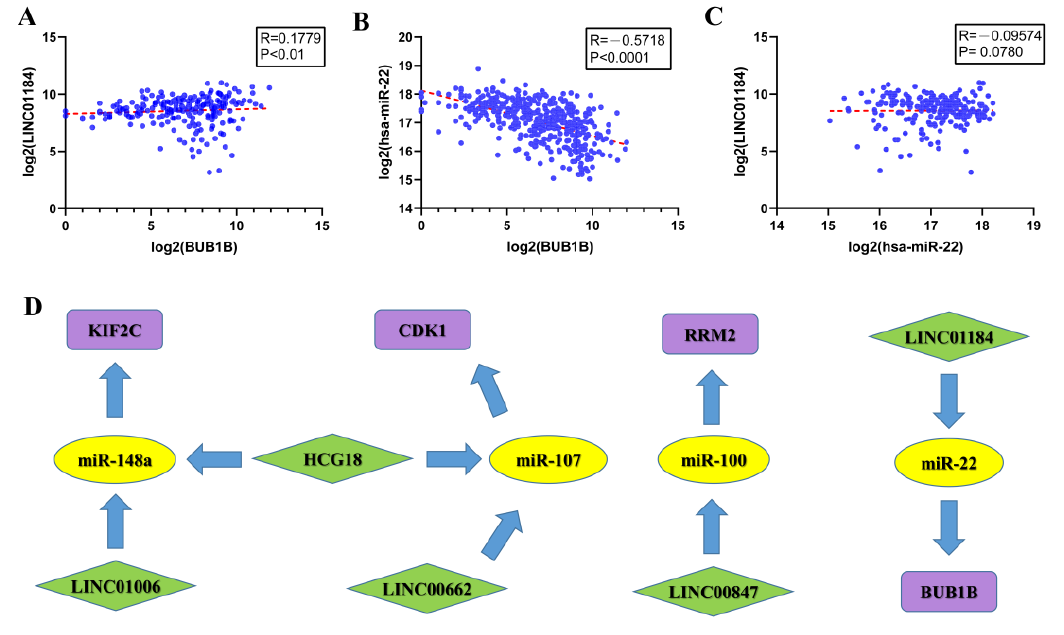
Figure 8. ( A ) Correlation between BUB1B and LINC01184. ( B , C ) Correlation between miR-22 and BUB1B and LINC01184. ( D ) Integration of the identified ceRNA network. Green diamonds stand for lncRNAs, purple rectangles stand for mRNAs, and yellow ellipses stand for miRNAs.